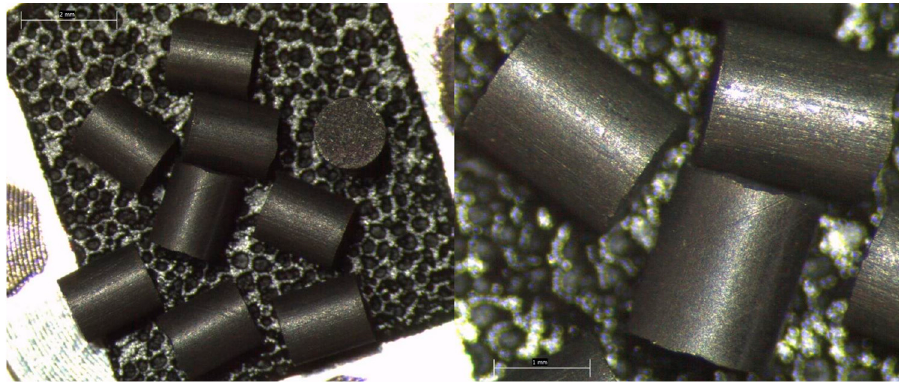
Figure 1. Optical micrograph of the metallic molybdenum pieces at different magnifications.